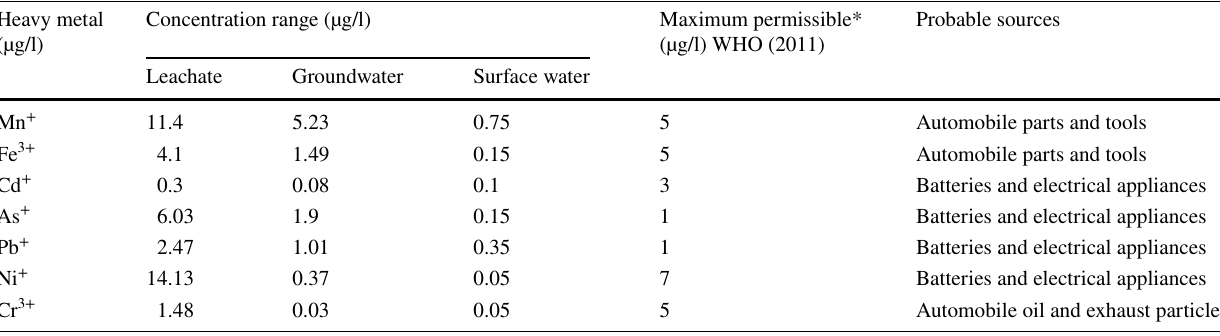
Table 3 Comparison of the heavy metal concentration results with drinking water standard